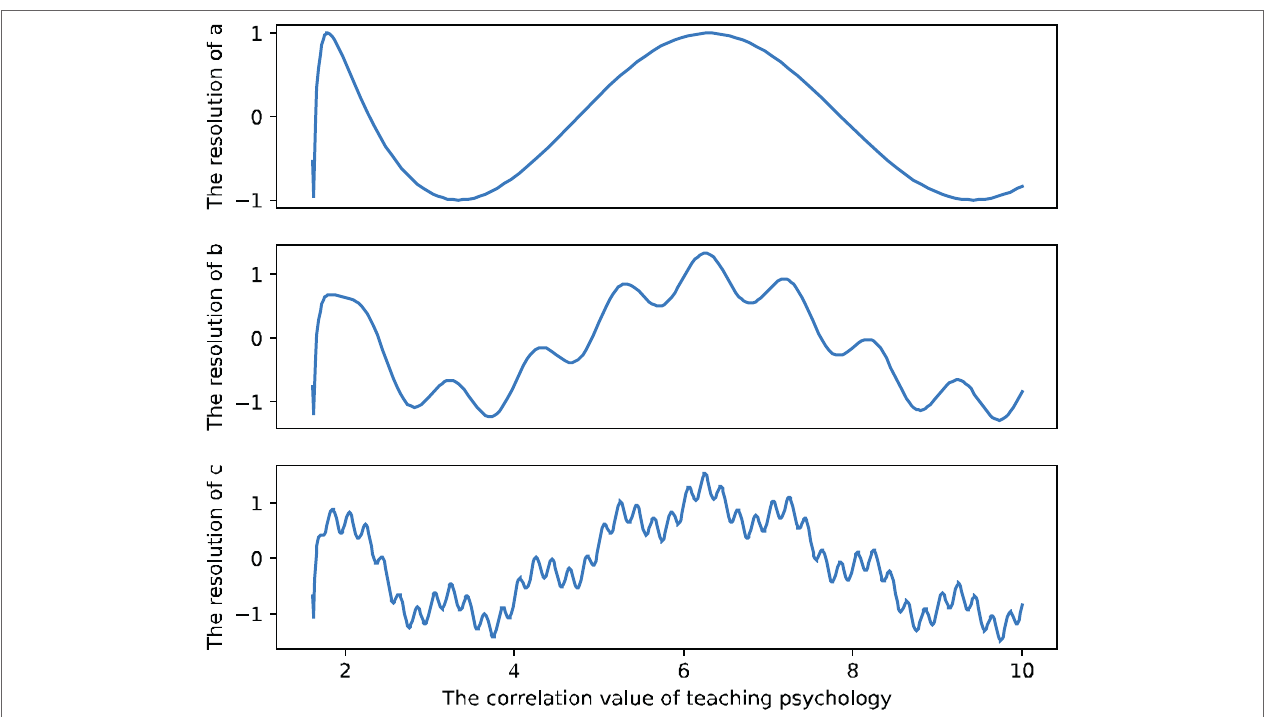
FIGURE 2 | The correlation measurement distribution of the independent components of teachers’ teaching